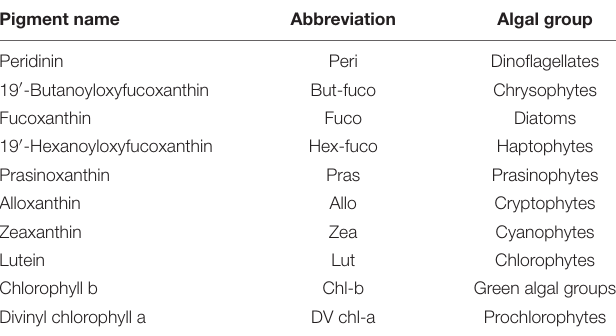
TABLE 2 | Biomarker pigments and the algal groups they represent (Egeland et al.,